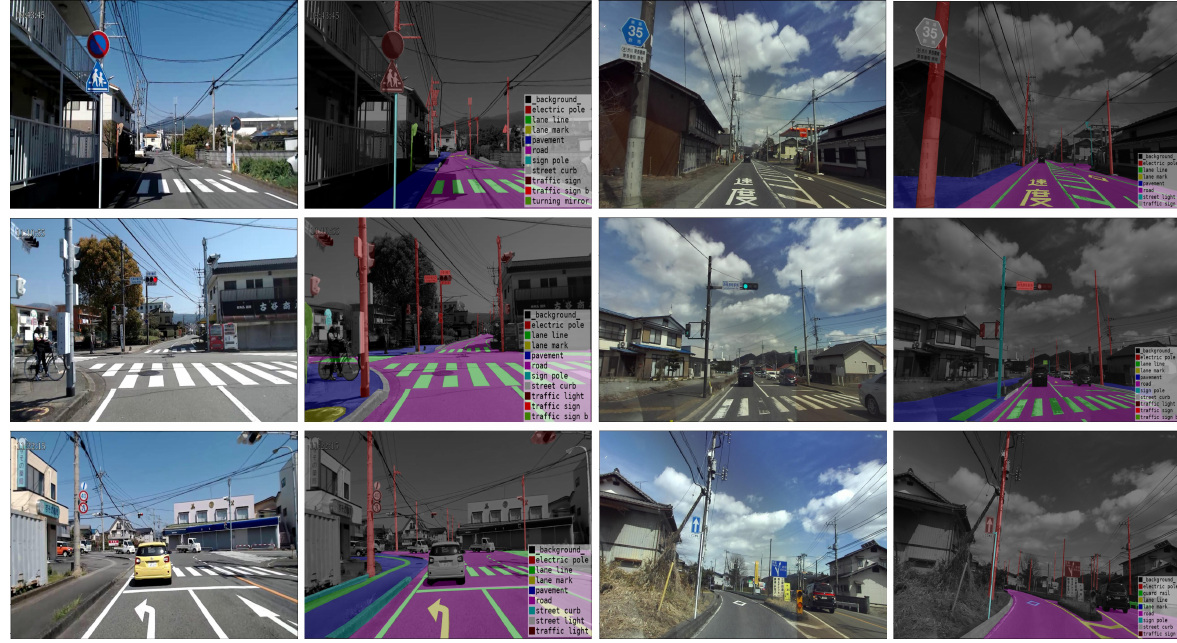
Figure 1. Sample annotation of Japanese road-view